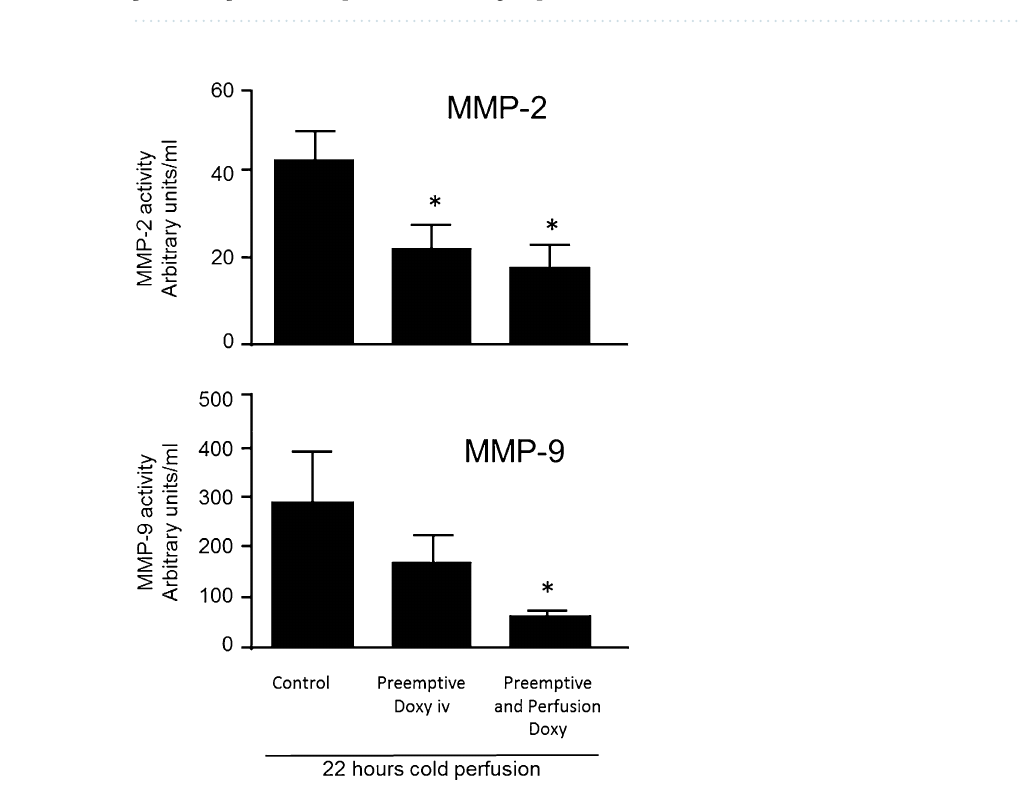
Figure 2. LDH and NGAL in perfusates from left kidneys after 22 h of machine cold perfusion at 4 °C. * p < 0.05, ** p < 0.01, compared to Control group.